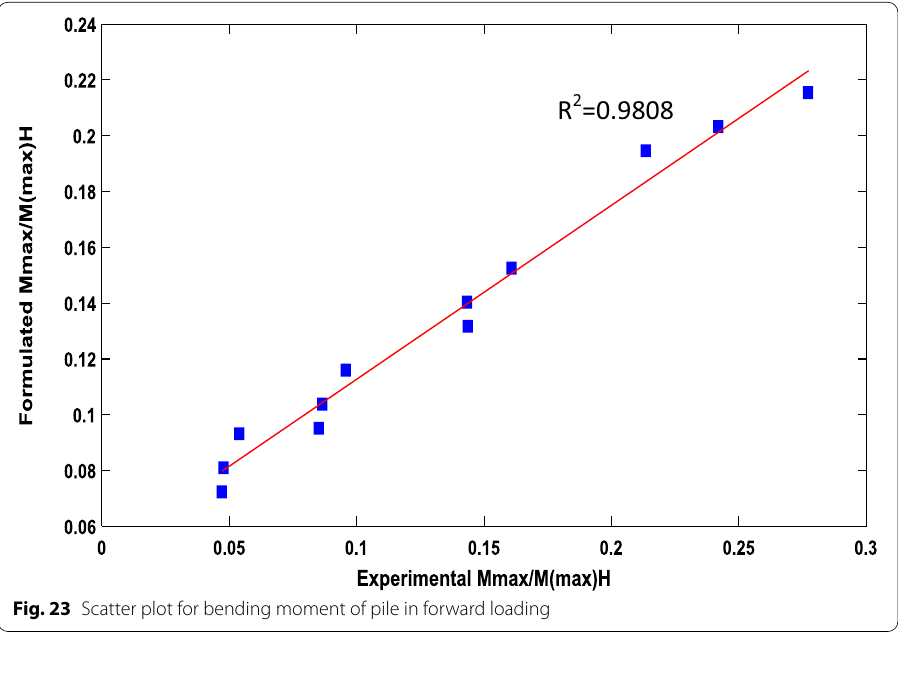
Fig. 23 Scatter plot for bending moment of pile in forward loading